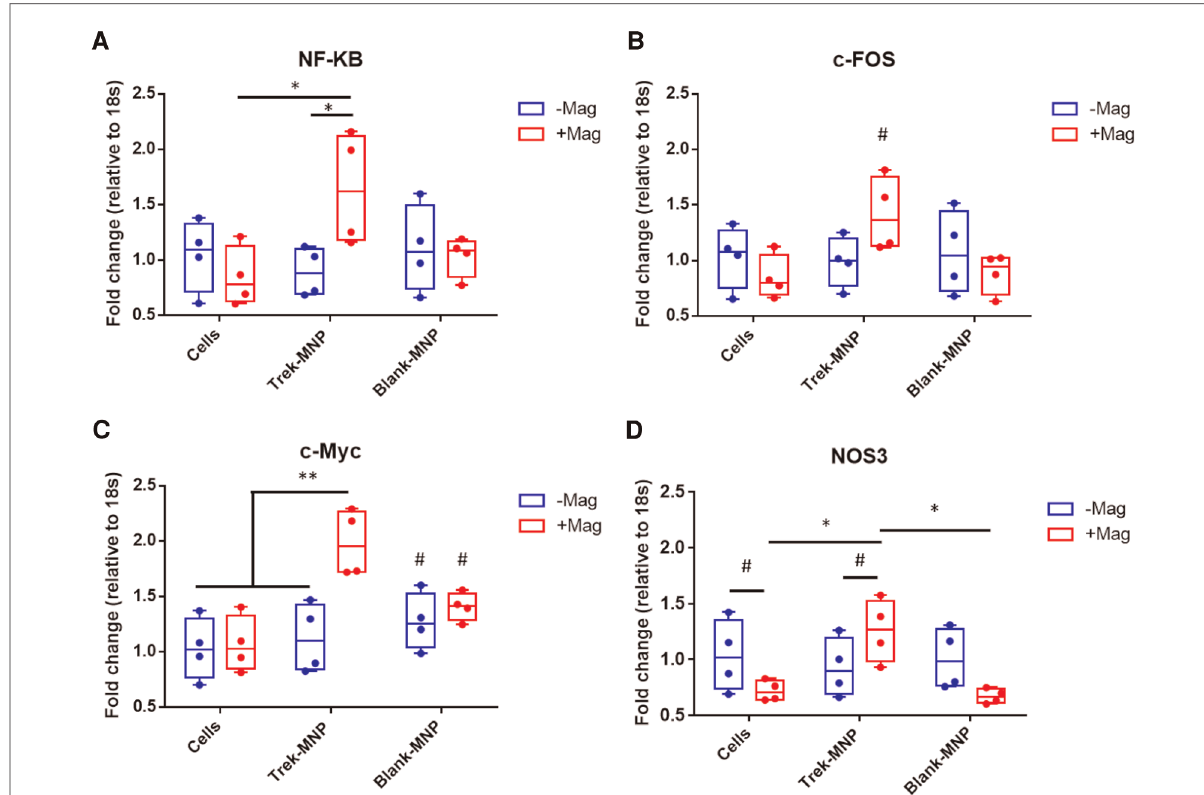
FIGURE 3 TREK-MNP induce stress-response gene expression in SH-SY5Y. Quantitative-reverse transcription-PCR was used to measure NF- κ B, c-Fos, c-Myc and NOS3 gene expression 24 h after treatment with MNP and or magnetic fi eld stimulation. Treatment with TREK-MNP and magnetic fi eld stimulation resulted in elevated NF- κ B expression compared to cells+magnet control group and Trek-MNP alone treatment. In contrast treatment with control (Blank)-MNP had no signi fi cant effect on NF- κ B expression ( A ). The same overall trend was also observed across the groups with c-Fos gene expression (not statistically signi fi cant), ( B ). TREK-MNP and magnetic fi eld stimulation also resulted in signi fi cantly elevated c-Myc expression vs. controls, whist control (Blank)-MNP caused no signi fi cant changes in c-Myc expression ( C ). NOS3 gene expression was signi fi cantly elevated after treatment with Trek-MNP+magnetic fi eld stimulation compared to the magnet control group (Cells+magnet) and Blank-MNP+magnet control group. In contrast treatment with control (Blank)-MNP with or without magnetic fi eld stimulation had no effect on NOS3 expression compared to the respective cell only controls ( D ). n =4, plots represent median fold change with IQR, * represents p <0.05, # represents p >0.05 (2-way